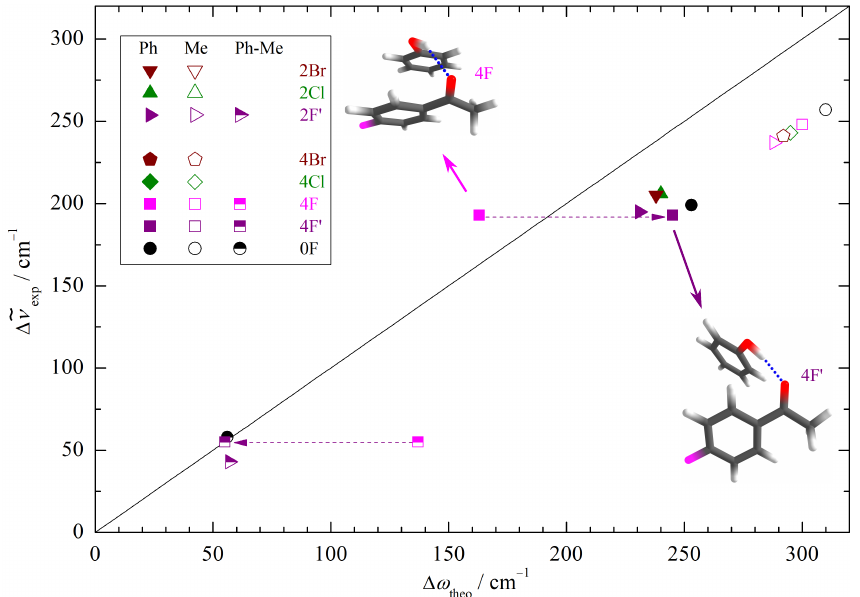
Figure 4. Correlation of the experimentally determined (anharmonic) OH complexation downshifts (Me, Ph) and splittings (Ph-Me) with the harmonic downshifts predicted at B3LYP-D3/ma-def2- TZVP level. The harmonic DFT shift overestimation, splitting prediction, and substitution trends are only uniform (symbol clustering) if the second-most stable Ph docking structure (4F’) is used for 4F (dashed